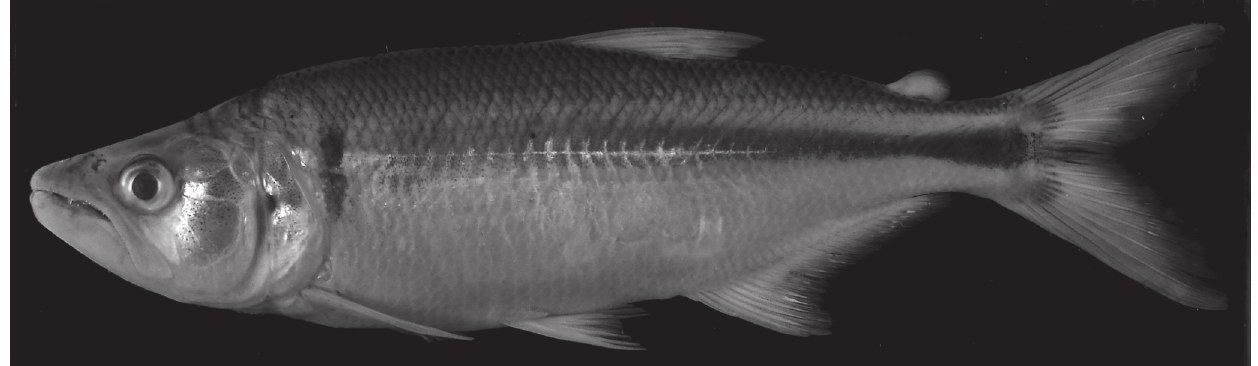
Fig. 1. Oligosarcus jacuiensis , holotype, MCP 28980, female, 153 mm SL, rio